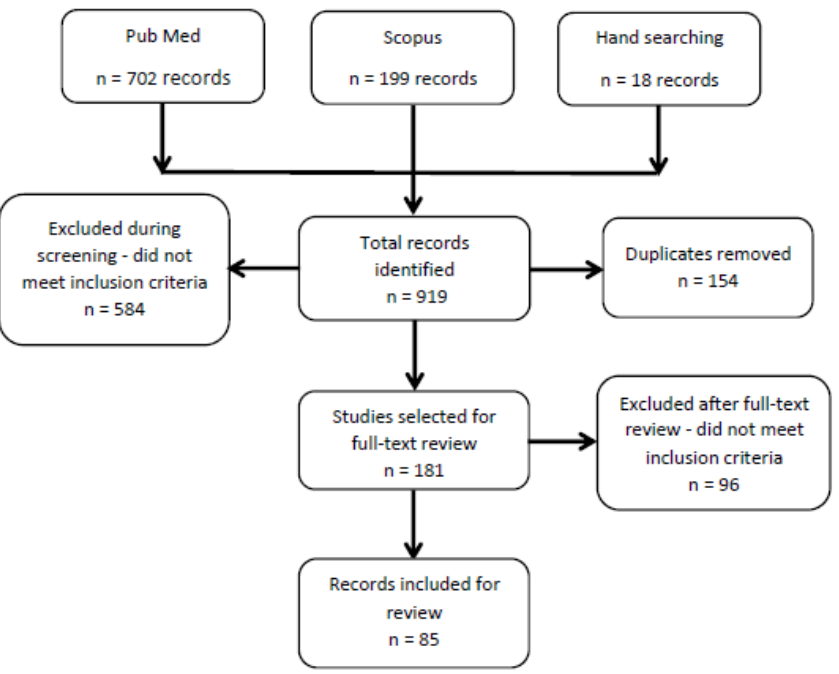
Figure 1. PRISMA flowchart for literature searches.